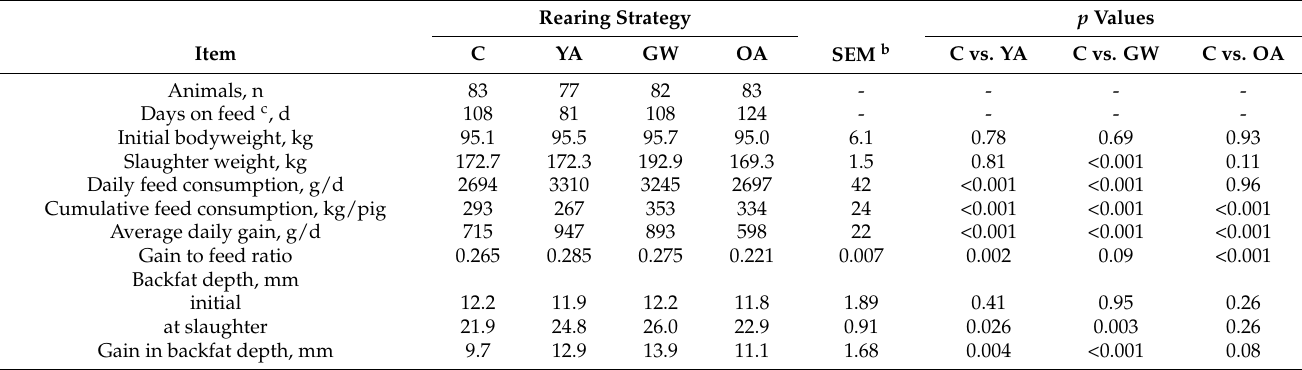
Table 4. Growth performance of heavy pigs raised according to the traditional rearing system (control, C), and three alternative strategies (younger age, YA; greater weight, GW; and older age, OA) a